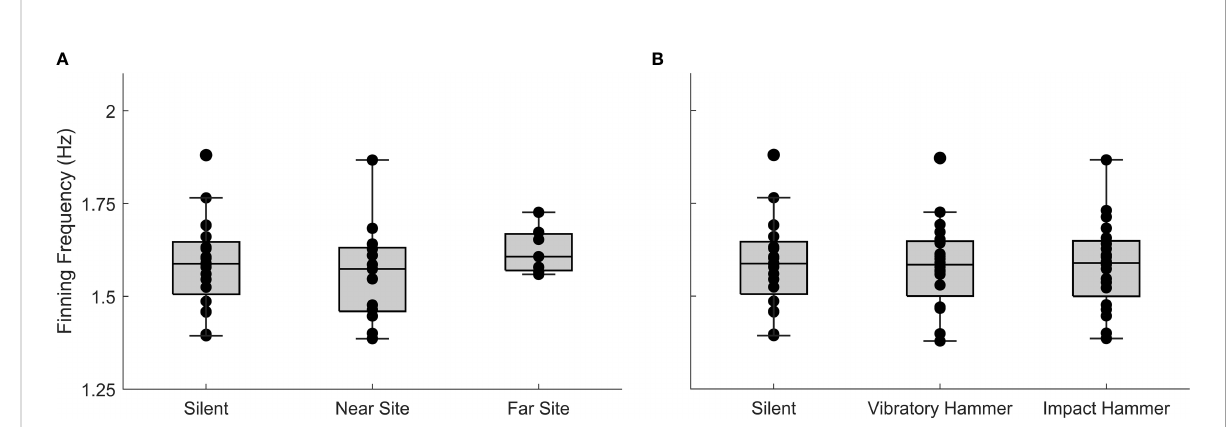
FIGURE 8 Focal squid fi nning rates averaged during over the impact pile driving periods, separated by (A) near and far site and the control quiet periods. (B) Finning rates for both near and far site separated by noise